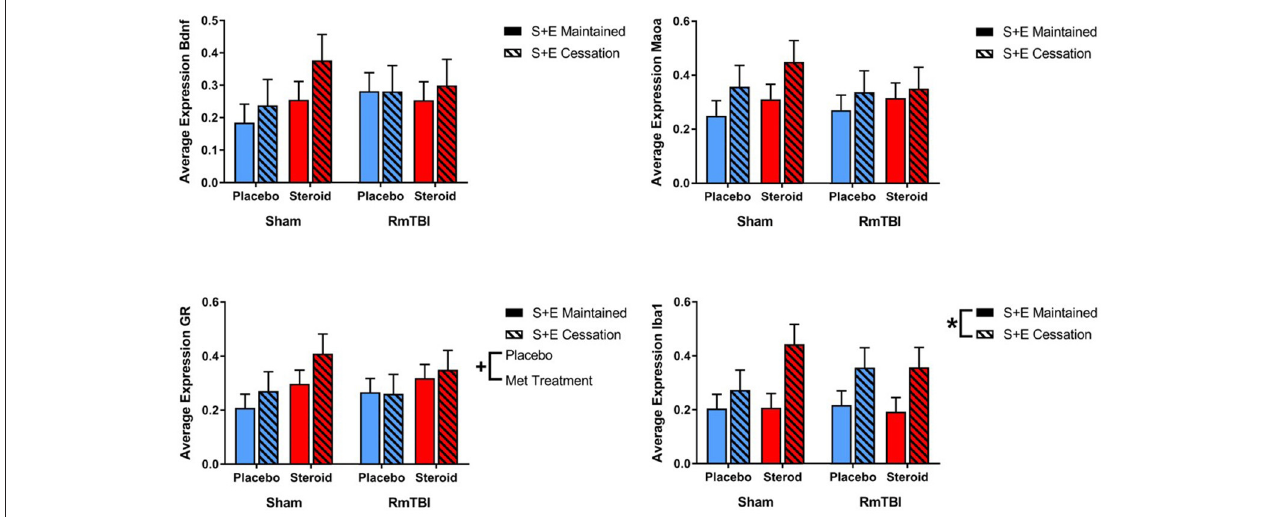
FIGURE 4 | Bar graphs displaying average mRNA expression in the HPC. Means ± standard error are displayed where *main effect for SEC and + main effect of Met treatment p ≤ 0.05. mRNA, messenger RNA; HPC, hippocampus; RmTBI, repetitive mild traumatic brain injury; S + E, steroid and